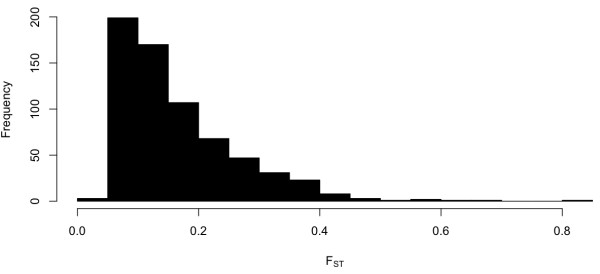
Distribution of FST from all polymorphic CNV regions.